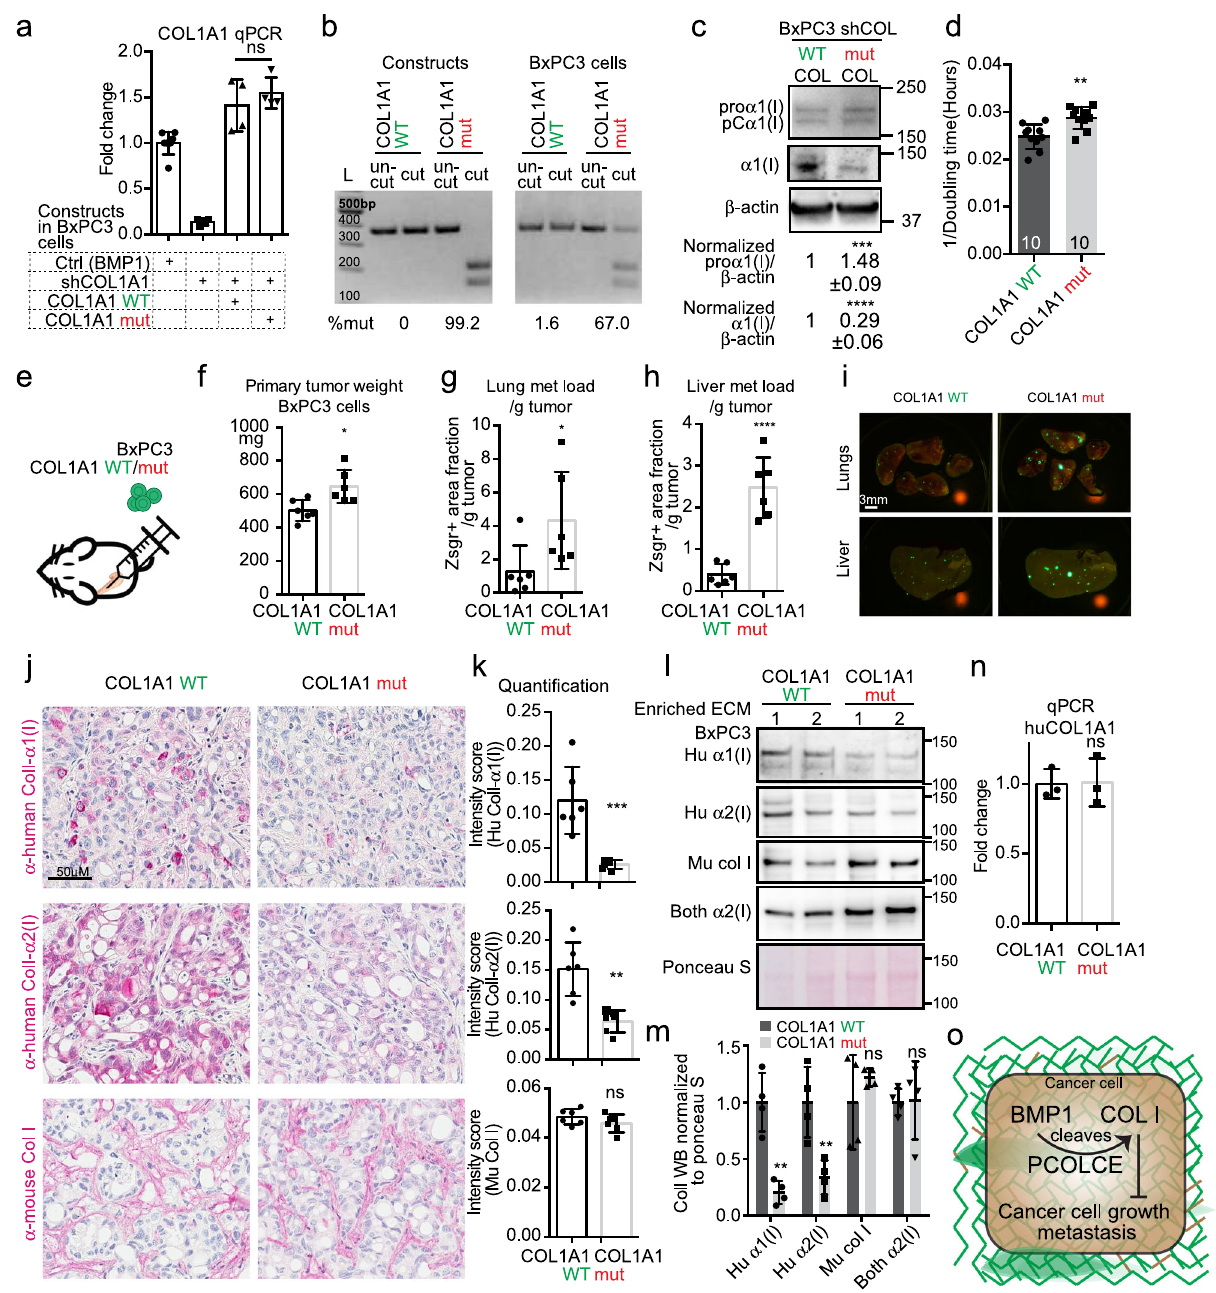
Fig. 7 COL1A1 mutated to remove the BMP1 cleavage site promotes tumor growth and metastasis. a Generation of cell clones that were knocked down for COL1A1 by shRNA targeting the 5 ′ UTR region and expressing either WT or mutated COL1A1. qPCR showed comparable expression levels for WT and mut COL1A1 ( N = 4). b Genotyping for the COL1A1 mutated transcript showed that 67% of all COL1A1 transcripts in the cells expressing COL1A1 mut were mutated (see Methods section). c Cultured cells expressing WT COL1A1 deposit more α 1(I) compared to those expressing mut COL1A1 (A) although COL1A1 RNA levels are comparable (see panel a ). c Shows images representative of three independent experiments with β -actin as a sample processing control. The quanti fi ed WB signal is represented as mean ± SD. d Cultured cells expressing COL1A1 mut have slightly faster growth rate than do cells expressing COL1A1, represented here by 1/doubling time in hours. e – i Orthotopic injection of BxPC3 cells expressing COL1A1 mut compared to cells expressing COL1A1 WT resulted in slightly increased primary tumor weight ( f ), and increased metastasis load in lung ( g ) and liver ( h ). Representative lung and liver metastasis images are shown in I . Mouse numbers are 6 for both groups. j , k IHC on xenograft tumor sections showed reduced staining intensities for cancer-cell-derived ColI but not for stroma-derived ColI staining upon BMP1 mutation. k is the quanti fi cation of the band intensities of four tumors from two independent experiments. l , m WB on enriched ECM samples from xenograft tumors showed decreased cancer-cell-derived (human) ColI deposition in COL1A1 mut tumors but a slight increase in mouse ColI. The WB band intensities were quanti fi ed in m ( N = 4). n COL1A1 expression was similar in the COL1A1 WT and mut xenograft tumors in species-speci fi c COL1A1 qPCR experiment using human-speci fi c COL1A1 and β -actin primers ( N = 3). o Working hypothesis summarizing the fi ndings: in cancer cells, BMP1 promotes increased ColI deposition, which can be enhanced by PCOLCE and disrupted by mutating the BMP1 cleavage site in α 1(I), and that, in turn, leads to suppression of tumor growth and metastasis. All p -values come from two-tailed Student ’ s t tests. All columns are represented by mean ±